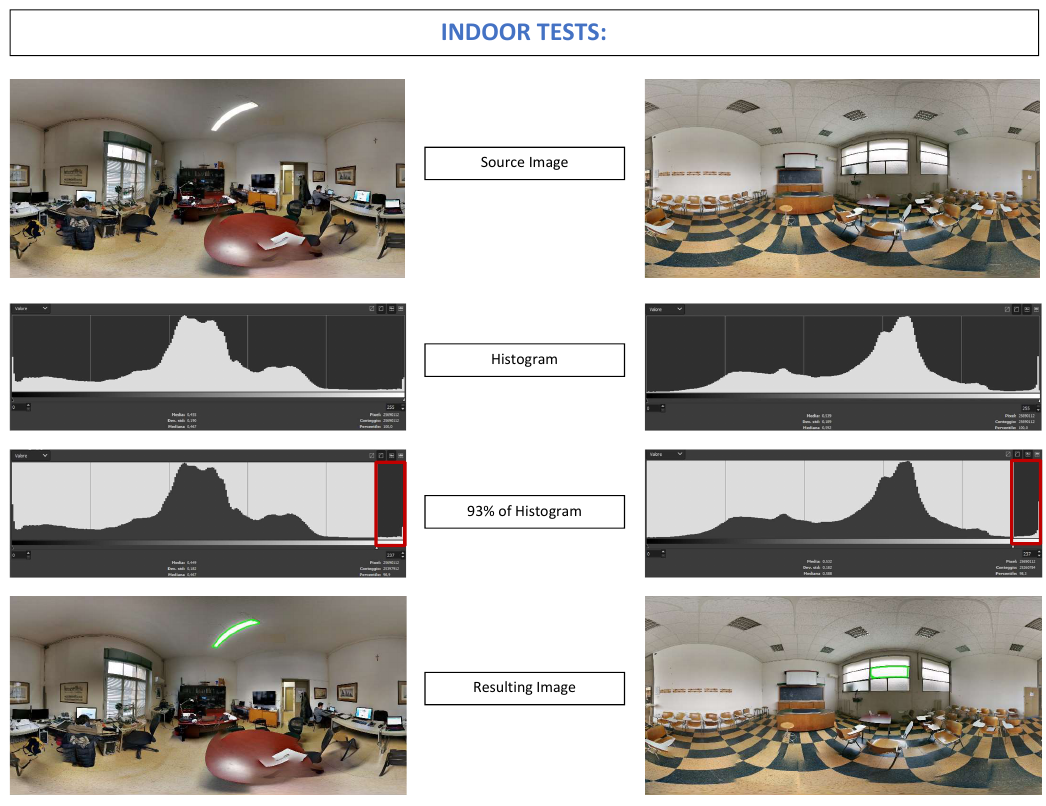
Figure 11. ARPAS on indoor